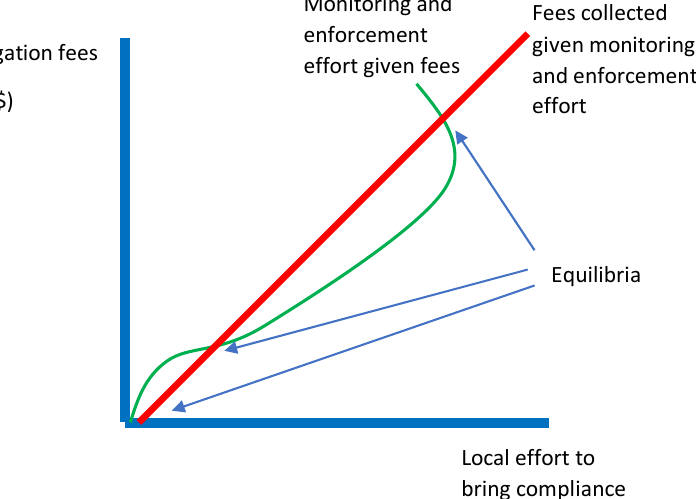
Figure 3. Hypothesised relationships between the monitoring and enforcement against fees paid / fees paid against monitoring and enforcement.